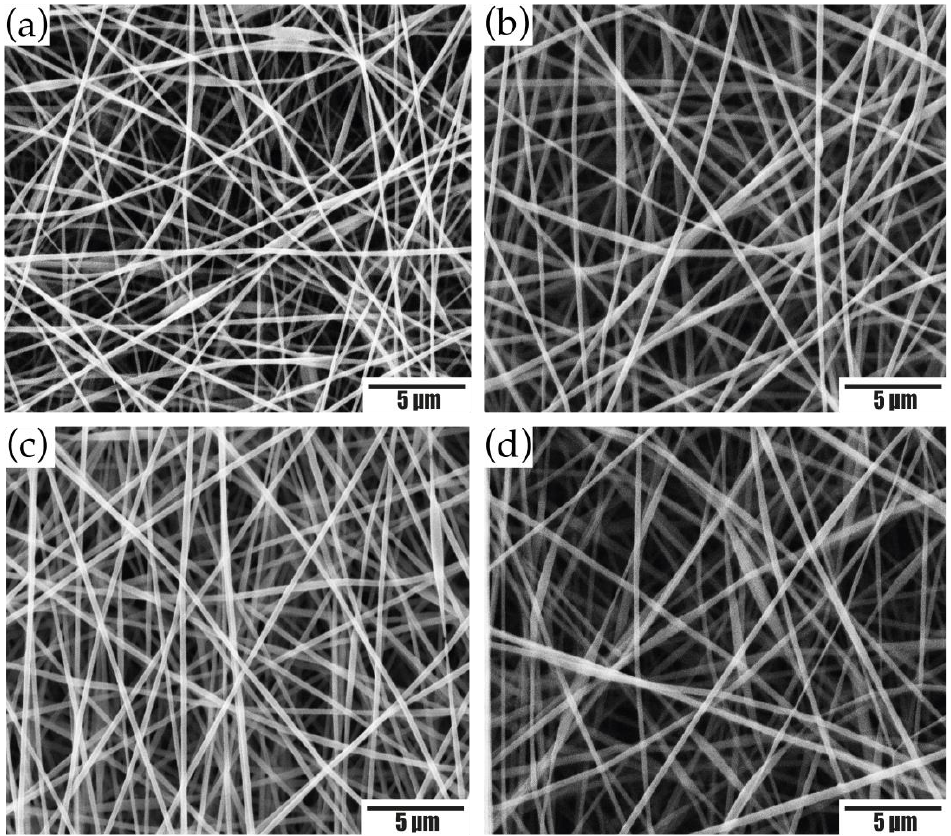
Figure 2. SEM micrographs of SFw/PEO electrospun membranes obtained at a volumetric ratio of 50:50, at distances of ( a ) 10 cm; ( b ) 15 cm; ( c ) 20 cm; ( d ) 25 cm. Scale bar, 5 μm.